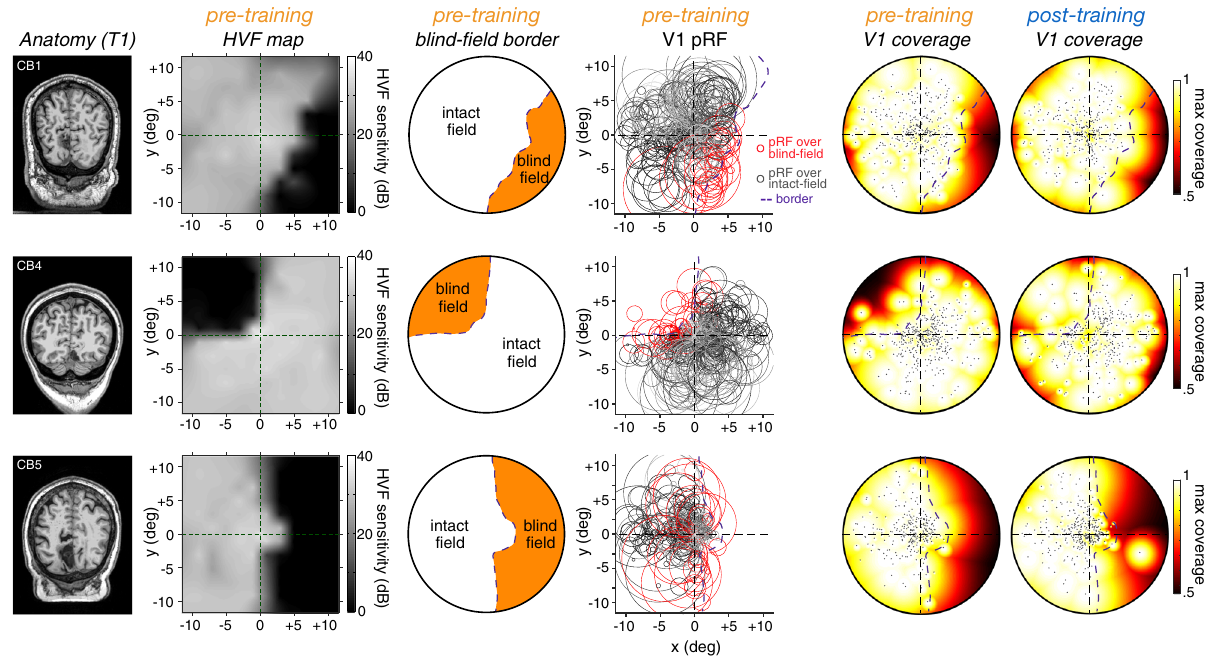
Fig. 6 Population receptive fi eld (pRF) and visual fi eld coverage before and following training. Anatomy (T1), pre-training HVF map, pre-training V1 pRFs, and resulting visual- fi eld coverage maps (maximum coverage) for pre-training and post-training V1 pRFs shown for 3 CB patients. The pRF method was used to estimate the position and size of the visual- fi eld area that best explained each voxel ’ s visually-evoked response. The initial (pre-training) HVF map was used to de fi ne the blind- fi eld border and determine whether each single pRF covered blind- fi eld regions or solely intact- fi eld regions with preserved HVF sensitivity. Single black dots on the coverage maps indicates the preferred center of each V1